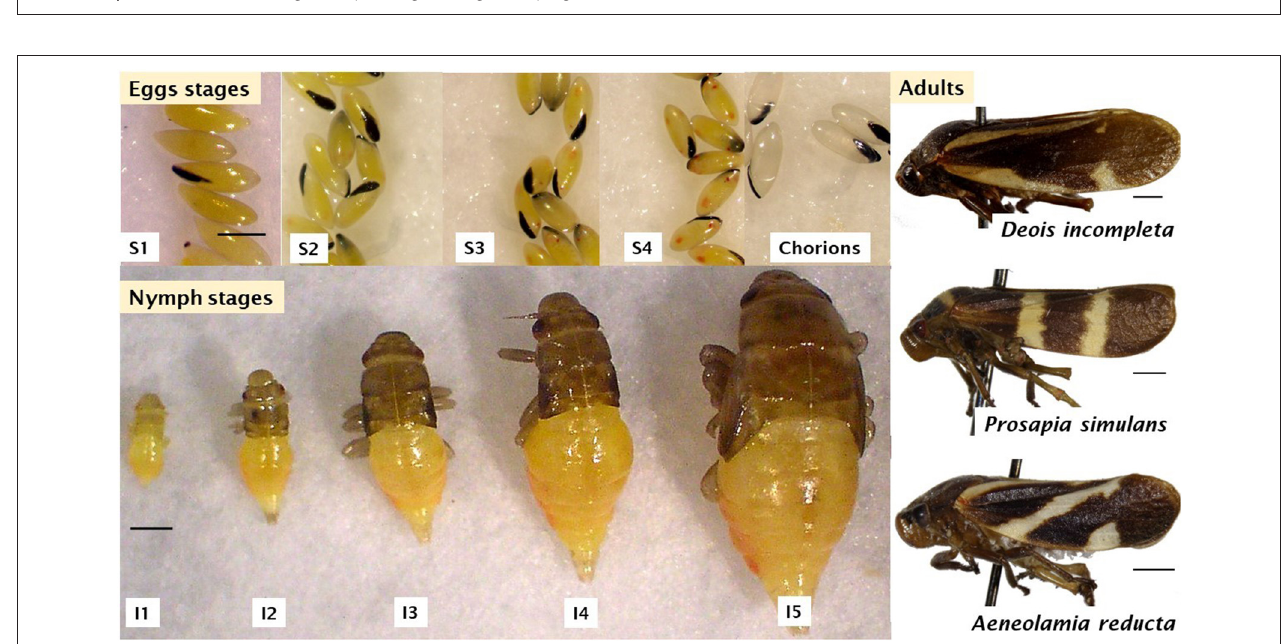
FIGURE 2 | Different stages of spittlebug: Eggs ( Aeneolamia varia ), nymph ( Prosapia simulans ), and adults. Scale bar represents a 1mm. Pictures taken from the archive of the forage entomology laboratory – CIAT.